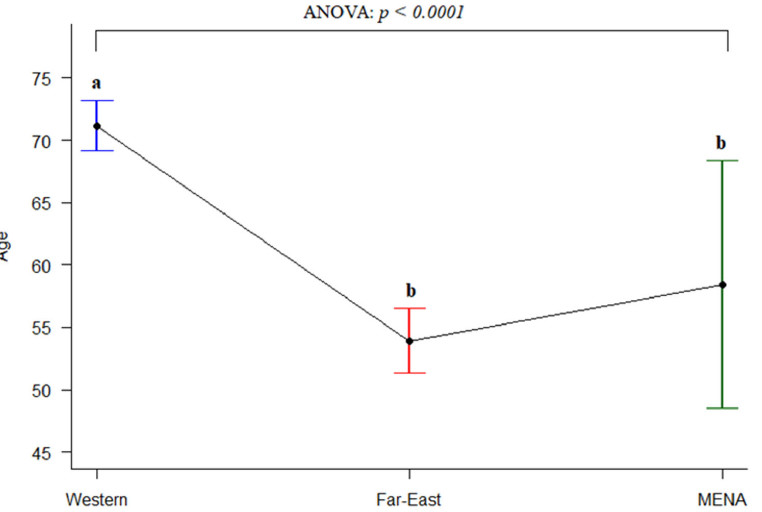
Figure 3. Comparison of the average age of onset for Western, Far East, and MENA populations (Western and Far East data were taken from [28–35]). Le tt ers show signi fi cant di ff erences: the same le tt er b is not signi fi cant, whereas a denotes statistically signi fi cant di ff erences between groups.